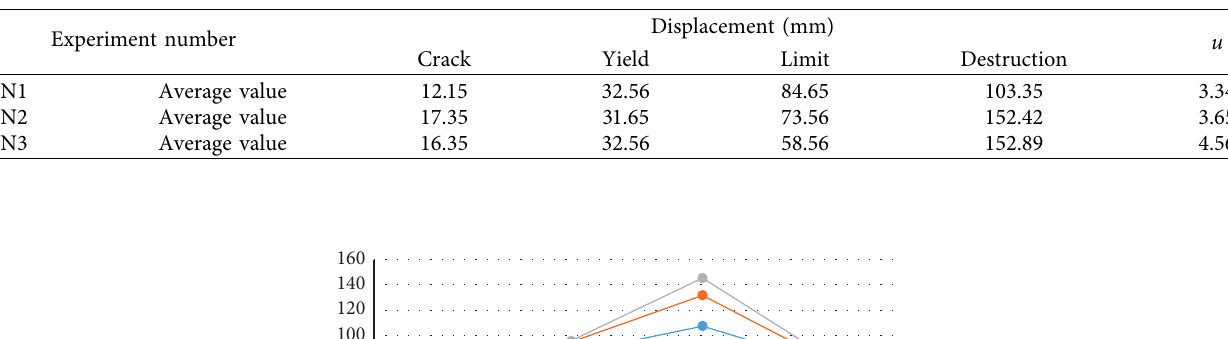
Table 2: Displacement and ductility coefficient of frame joints.